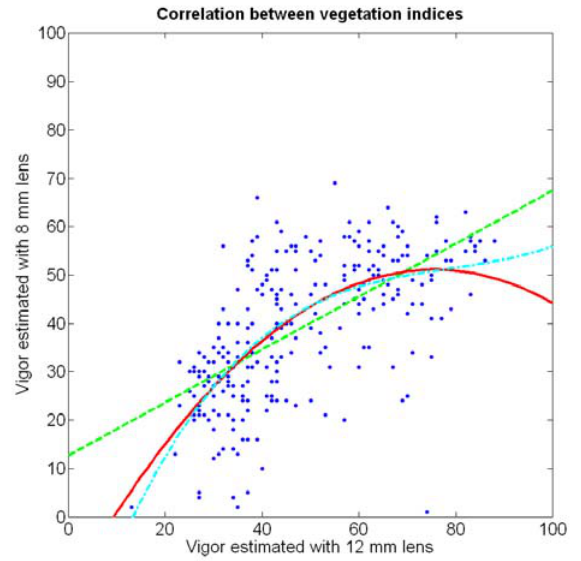
Figure 22. Correlation between alternative vegetation indices V-8 and